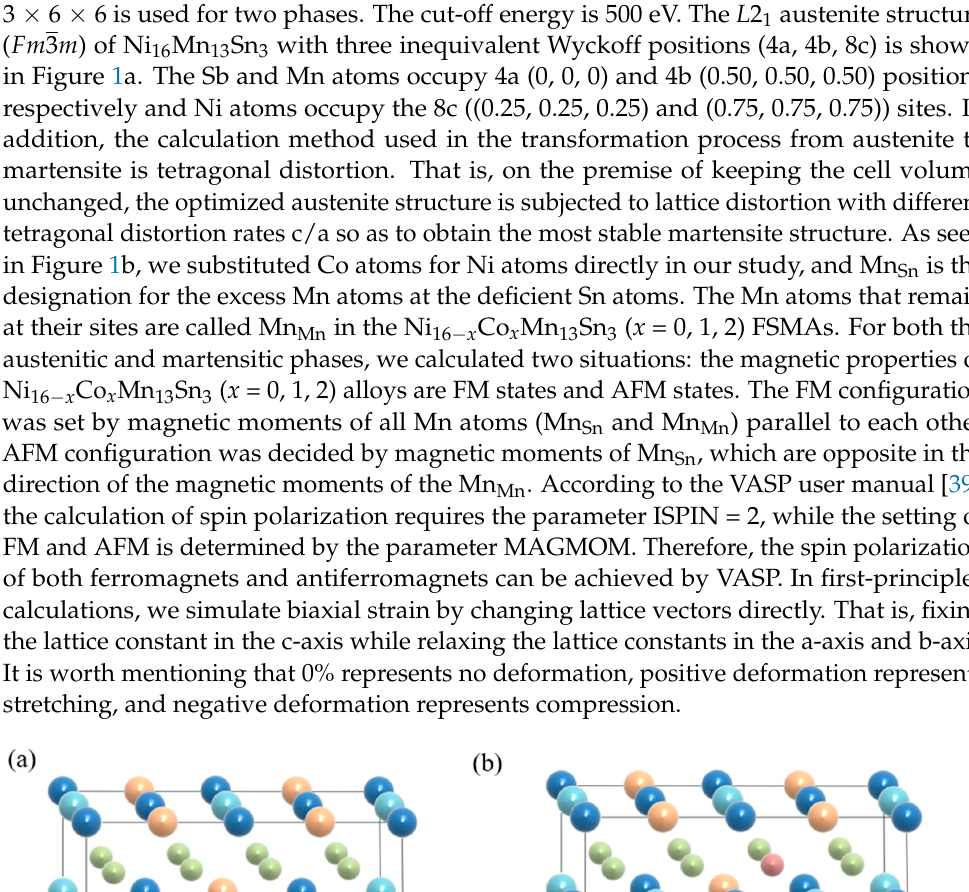
Figure 1a. The Sb and Mn atoms occupy 4a (0, 0, 0) and 4b (0.50, 0.50, 0.50) positions re-